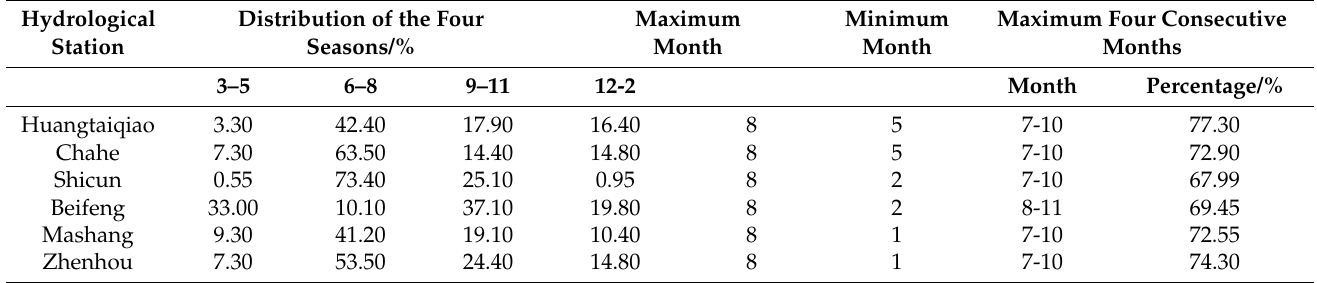
Table 4. Annual distribution of annual average runoff for each station in Xiaoqing River basin.